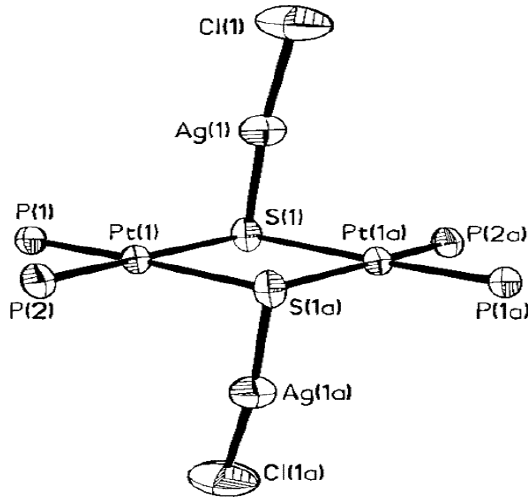
Figure 3. Structure of [(PPh